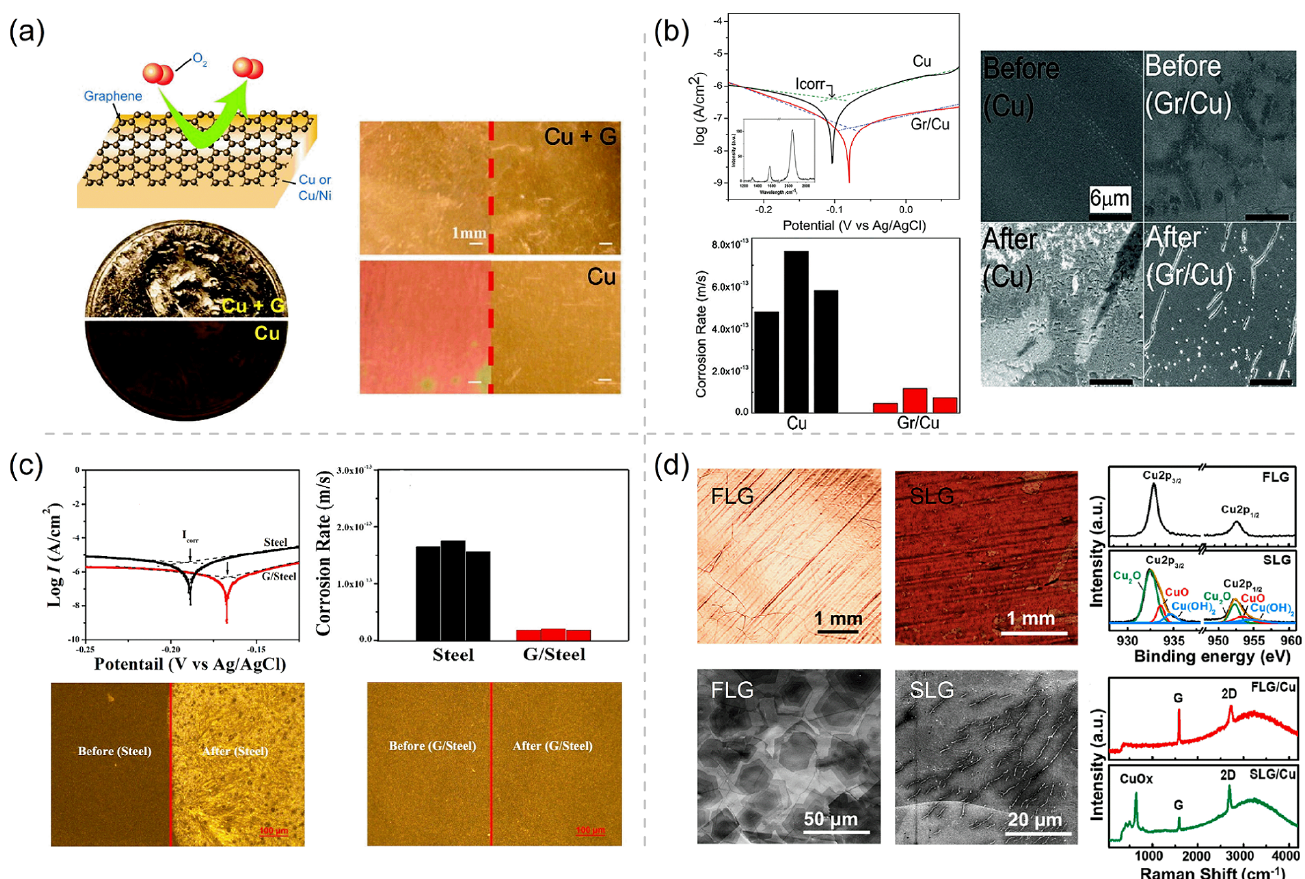
Figure 1. ( a ) Schematic depicting graphene (Gr) film as a chemically inert diffusion barrier, photograph showing Gr-coated and uncoated penny after 30% H 2 O 2 corrosion, and photographs of Cu and Cu/Ni foils with and without Gr coating taken before and after annealing in air (4 h, 200 ◦ C). Adapted with permission from Reference [35]. Copyright 2011, American Chemical Society. ( b ) Tafel plots and corrosion rates of Cu and Gr/Cu samples and scanning electron microscope (SEM) images of Cu and Gr/Cu sample before and after cyclic voltammetry (CV) scanning. Adapted with permission from Reference [36]. Copyright 2012, American Chemical Society. ( c ) Tafel plots and corrosion rates of bare stainless steel (labeled as steel) and Gr/stainless steel (labeled as Gr/steel) samples in 5% sea salt solution, and their optical images before and after the electrochemical anticorrosion testing. Adapted with permission from Reference [39]. Copyright 2016, American Chemical Society. ( d ) Optical and SEM micrographs of few-layer Gr/Cu (FLG/Cu) and single-layer Gr/Cu (SLG/Cu) after corrosion, and X-ray photoelectron spectroscopy (XPS) and Raman spectra of FLG/Cu and SLG/Cu. Adapted with permission from Reference [40]. Copyright 2021, American Chemical